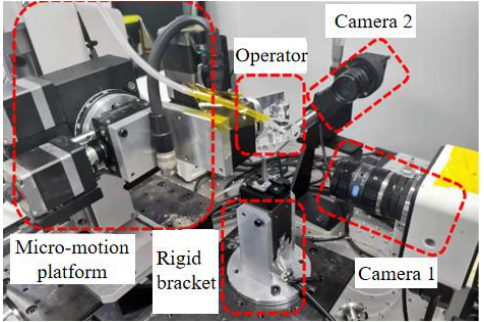
Figure 11. Rigid assembly platform of TMP component and hohlraum.